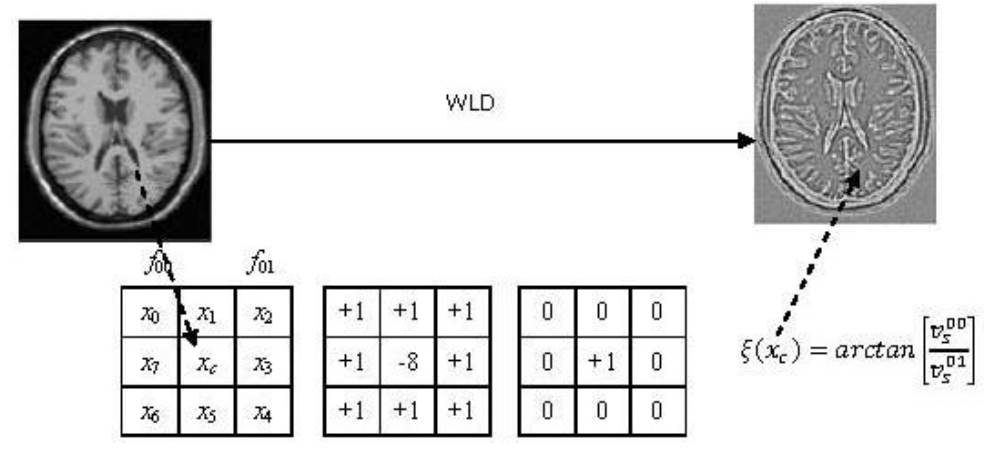
Figure 2. Differential excitation of Weber local descriptor.